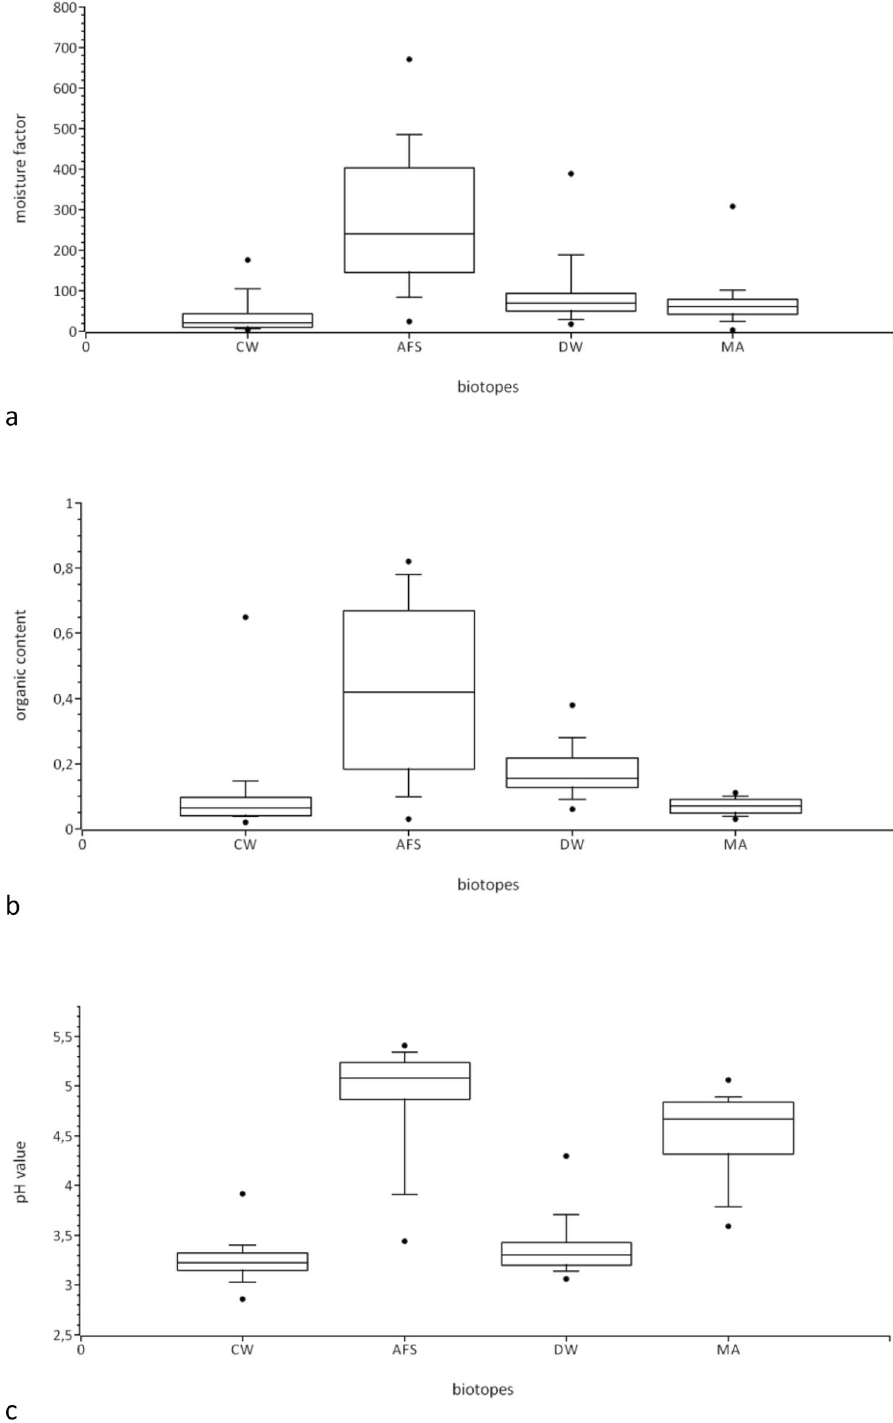
Figure 2. All box plots ( a – c ) comprise 25th and 75th percentiles (whisker box) and include the median (central line). Error bars represent 10th and 90th percentiles, with the dots delineating minimum and maximum data points. ( a ) Boxplots of the soil moisture factors measured in the four biotopes ( CW Coniferous woodland, AFS Alder on fen site, DW Deciduous woodland, MA Marsh area) in region 3. ( b ) Boxplots of the organic contents measured in the four biotopes ( CW Coniferous woodland, AFS Alder on fen site, DW Deciduous woodland, MA Marsh area) in region 3 (values between 0–1 correspond to 0–100%). ( c ) Boxplots of the pH values measured in the four biotopes. ( CW Coniferous woodland, AFS Alder on fen site, DW Deciduous woodland, MA Marsh area) in region